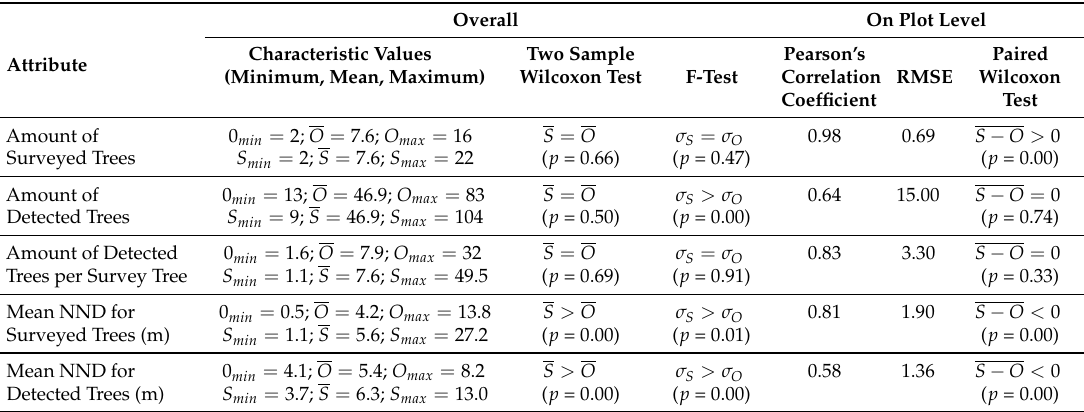
Table 3. Evaluation results of the synthetic training data S compared to the original data O . NND: nearest-neighbor